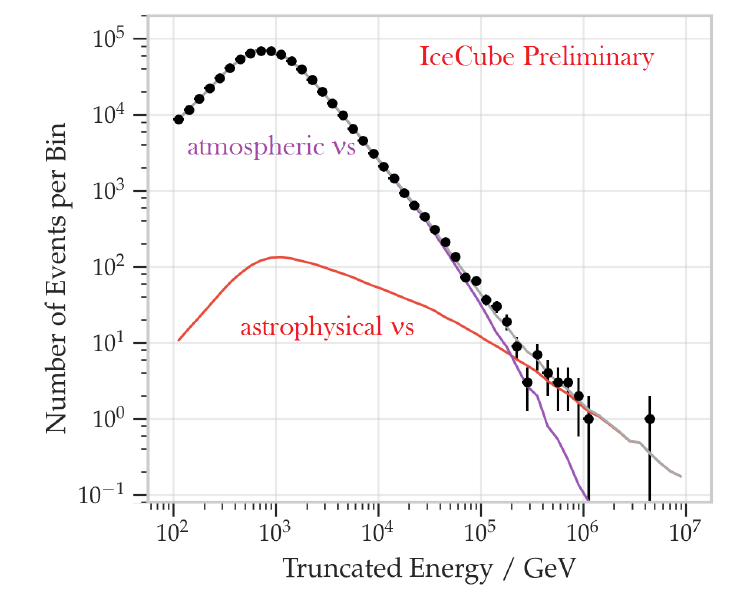
Figure 9. Unfolded ν µ event distribution from the passing muon sample in IceCube. The data (crosses) are compared to the best-fit fluxes for atmospheric and astrophysical neutrinos. From the arXiv version of